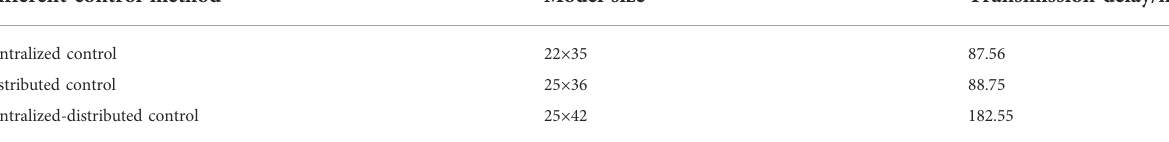
TABLE 5 Comparison of model effects of different control